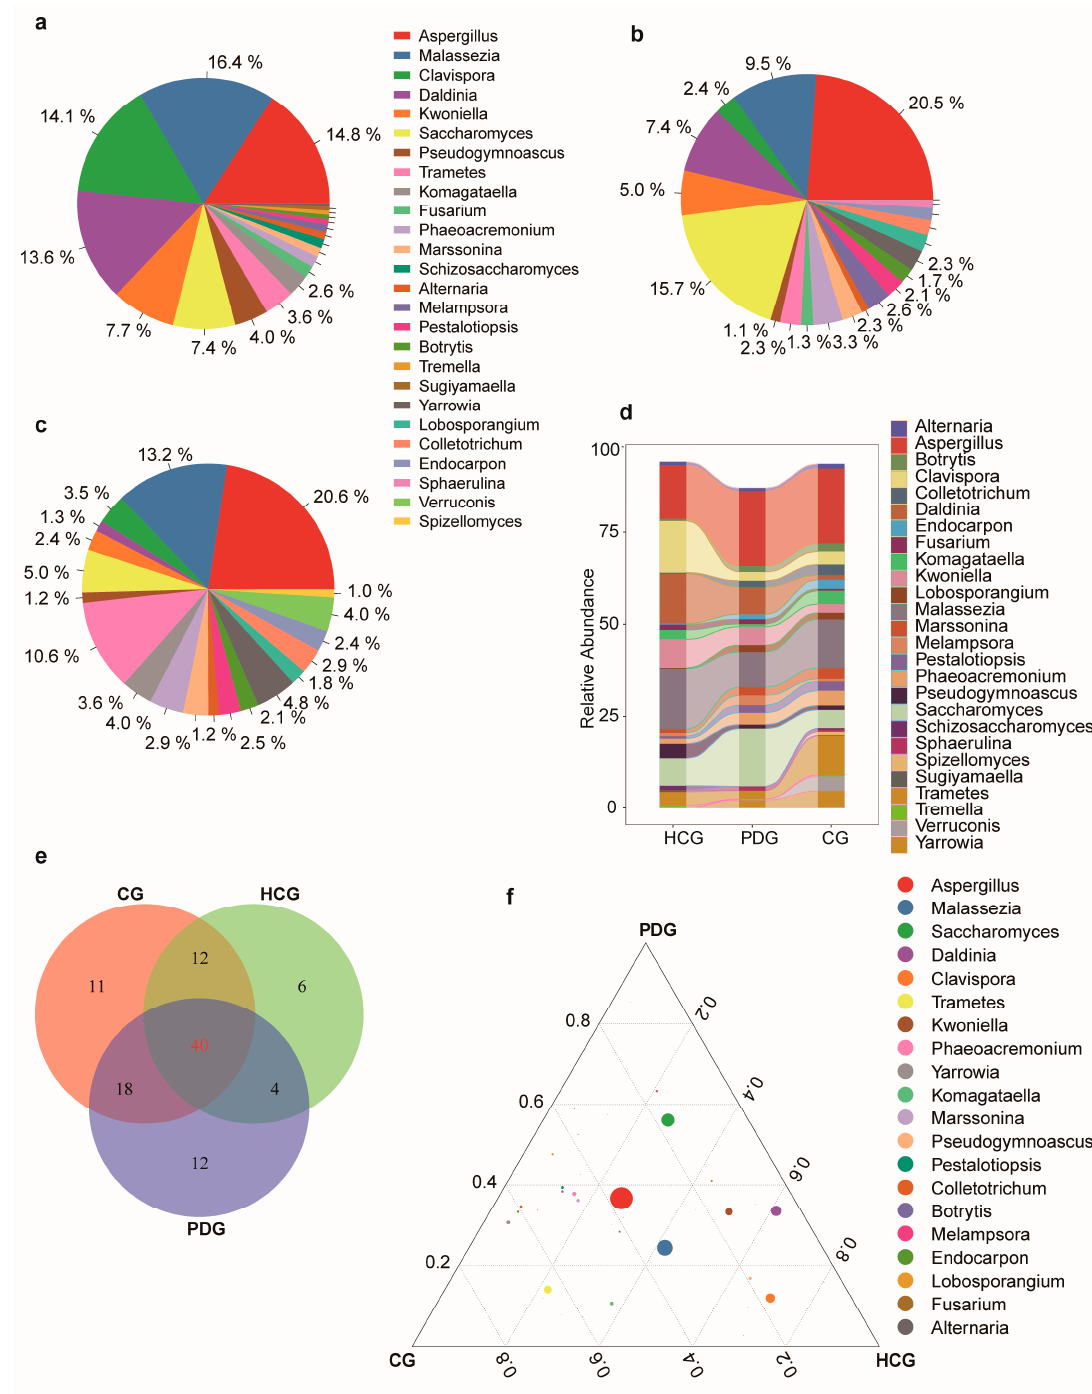
Figure 2. Oropharyngeal fungal alterations among HCG, PDG and CG. Average compositions of relative abundance of the top 20 fungal genera for ( a ) HCG, ( b ) PDG, ( c ) CG. ( d ) Alterations in the top 20 fungal genera among the three groups. ( e ) The shared and unique genera of the three groups. ( f ) Ternary plots depicting the 244 shared fungal genera of the three groups. The sum of the proportion for one specific fungus in the three groups was set to 1, and the proportion of one specific fungus in each group is equal to its corresponding relative abundance divided by the relative abundance sum of this fungus in the three groups. The sizes of the circles represent the relative abundance of the genus. HCG: healthy control group. PDG: period of disease group. CG: convalescent